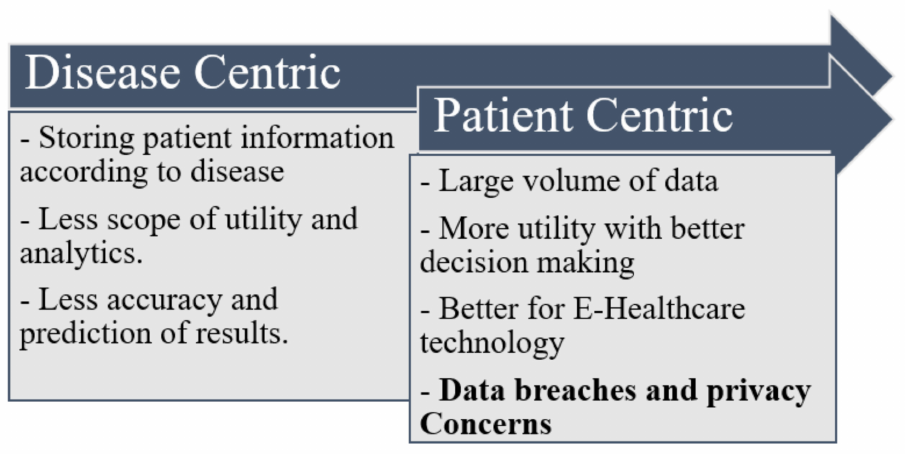
Figure 1. Disease- and patient-centric healthcare